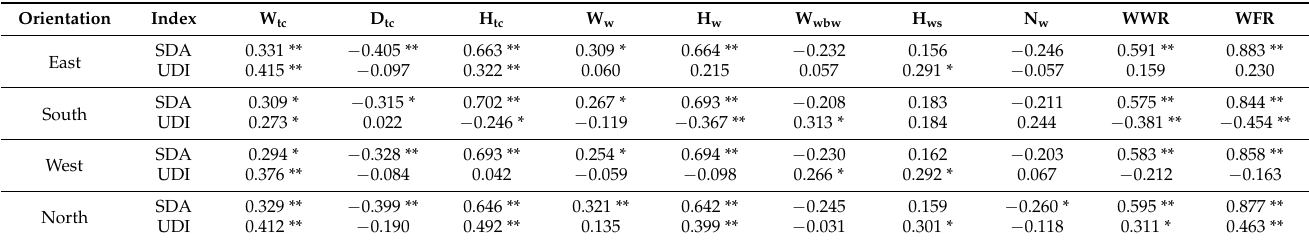
Table 2. Correlation analysis results of interior space and window geometry parameters with sDA 300,50% and UDI 100–2000